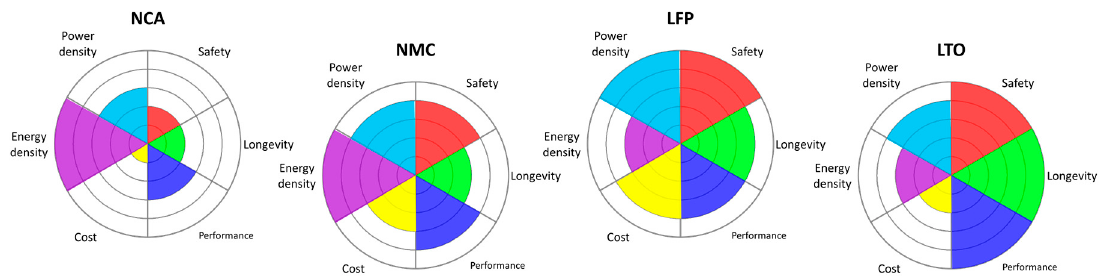
Figure 2. Performance properties of electrochemical cells: NCA—Lithium Nickel Cobalt Aluminum Oxide, NMC—Lithium Nickel Manganese Cobalt Oxide, LFP—Lithium Iron Phosphate, LTO—Lithium Titanate.